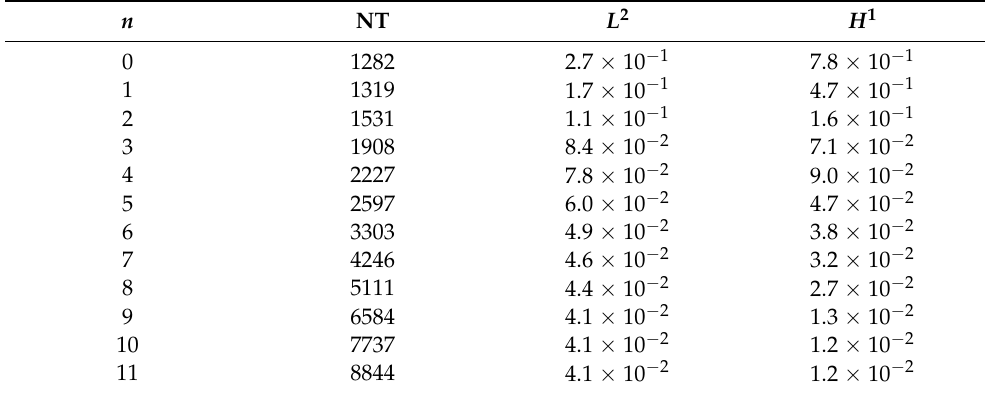
Table 4. Error in L 2 norm and H 1 seminorm for example 2 obtained with the residual-based error estimator.